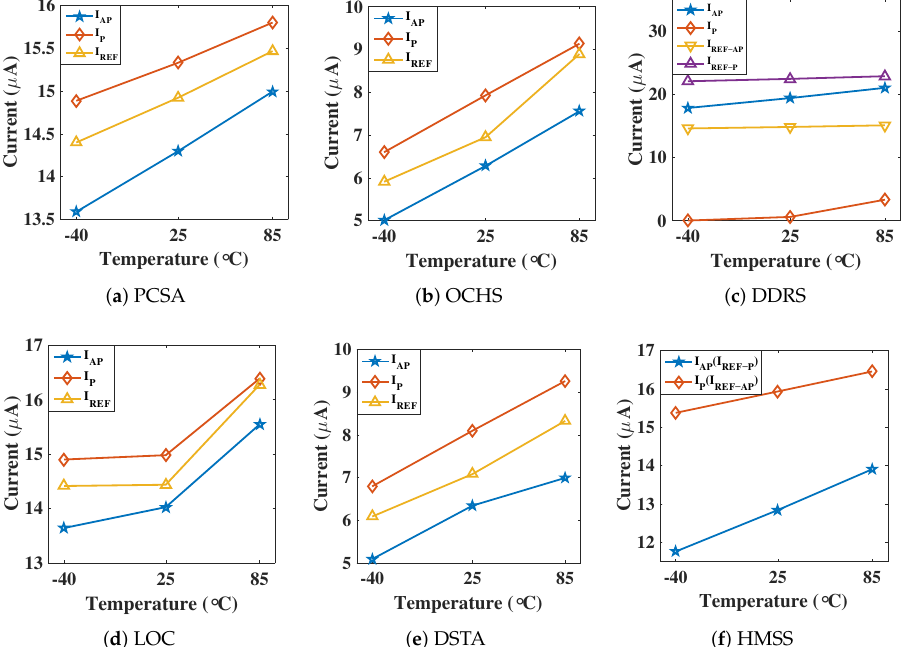
Figure 9. Sensing current versus temperature analysis in different sensing circuits: ( a ) PCSA, ( b ) OCHS, ( c ) DDRS, ( d ) LOC, ( e ) DSTA, ( f ) HMSS. The sensing margin at low temperature is greater than high temperature. Note that the sensing current in different circuits are lower than MTJ critical current ( I c 0 = 50